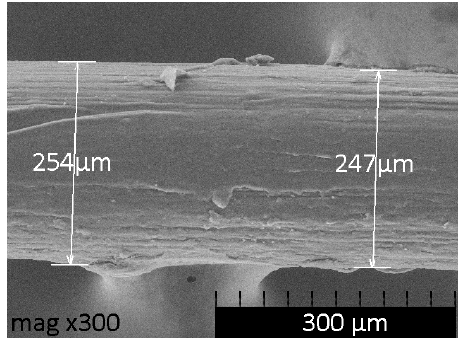
Figure 1. SEM image of the untreated HDPE/SKL (90:10) fiber.